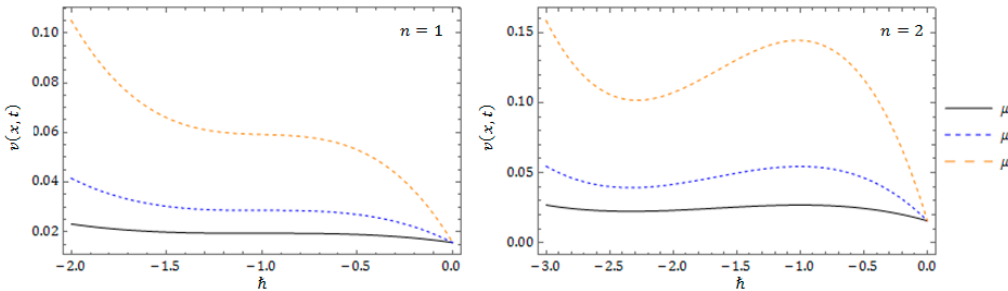
Figure 3 . ℏ -curves obtained for 𝑣(𝑥, 𝑡) in case (𝑖) with diverse 𝜇 when 𝜌 = −0.5,𝜀 = 0.5,𝑥 = 1 , and 𝑡 = 0.01 at distinct 𝑛 .